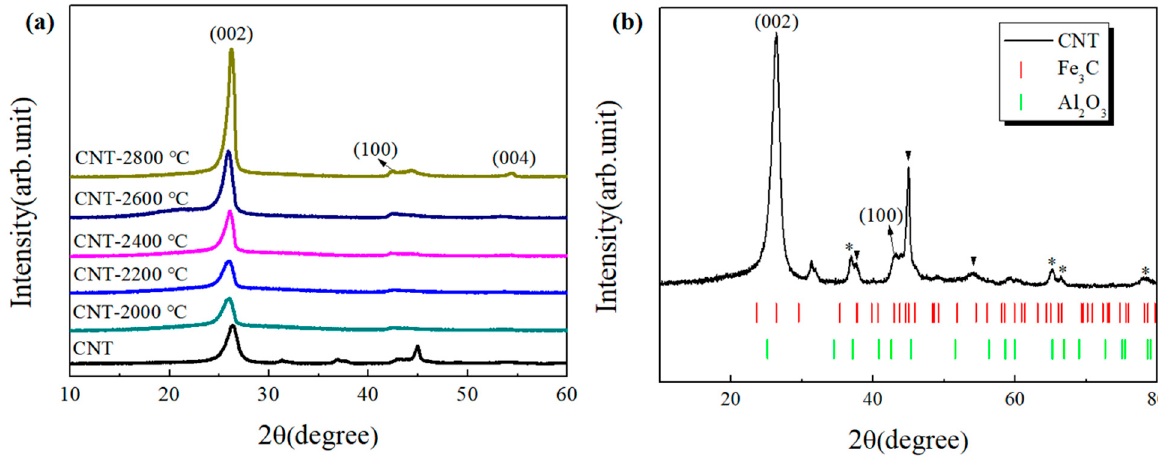
Figure 2. ( a ) XRD of MWNTs annealed at different temperature for 180 min, ( b ) Impurity distribution and peak level calibration of undiluted MWNTs. Peaks with ▼ mark are iron carbide, while peaks with ∗ mark are aluminum oxide.